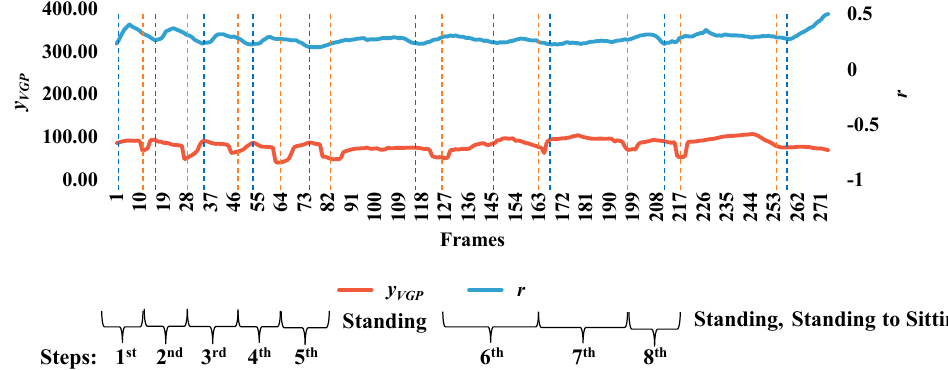
Figure 11. Two extracted features— y VGP ( y coordinate of the virtual grounding point ( VGP )) and aspect ratio ( r )—which can provide information on the number of steps for a person.